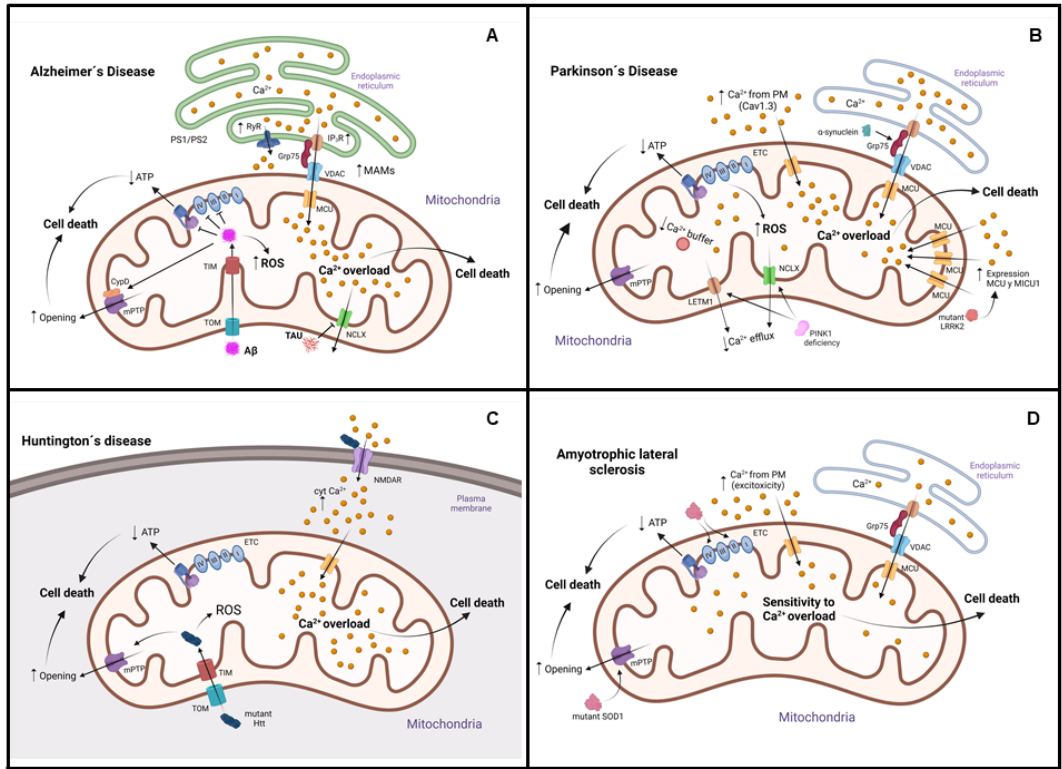
Figure 2. Dysregulation of mCa 2+ in neurodegenerative disorders. ( A ) In Alzheimer’s disease, amyloid-beta aggregates (A β ) enter mitochondria through the translocases TOM and TIM. Inside, they interact with respiratory chain complexes III, IV, and ATP synthase, leading to ATP synthesis reduction and with CypD, leading to mPTP opening, potential membrane collapse, and cell death activation. Additionally, there is an excessive level of mCa 2+ caused by increased IP3Rs and RyR activity dysregulation of voltage-operated channels. Moreover, Tau protein decreases mCa 2+ efflux by suppressing NCLX. ( B ) In Parkinson’s disease, α -synuclein interacts with the chaperone glucose- regulated protein 75 (Grp75), increasing endoplasmic reticulum–mitochondria communication and mCa 2+ . PTEN-induced kinase 1 (PINK1) deficiency results in mitochondrial calcium overload and ROS production by decreased activity of NCLX and LETM1. ( C ) In Huntington’s disease, mHtt (mutant huntingtin) enters mitochondria through the translocases TOM and TIM and causes NMDA receptor overactivation in PM, resulting in increased calcium influx and significant mitochondrial depolarization, and ATP synthesis reduction. Additionally, mHtt decreases the Ca 2+ threshold necessary to trigger mPTP opening. ( D ) In amyotrophic lateral sclerosis, SOD1 mutant has an early increase in mCa 2+ by endoplasmic reticulum overload and increased cytosolic calcium, which causes loss of mitochondrial membrane potential. In addition, this mutant decreases the activity of respiratory chain complexes I, II, and IV and reduces ATP synthesis. There is an increased mitochondrial susceptibility to Ca 2+